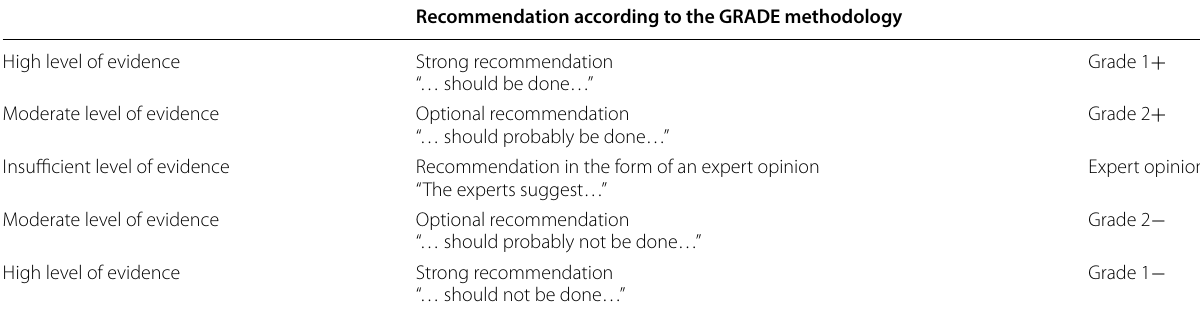
Table 1 Recommendations according to the GRADE methodology Recommendation according to the GRADE